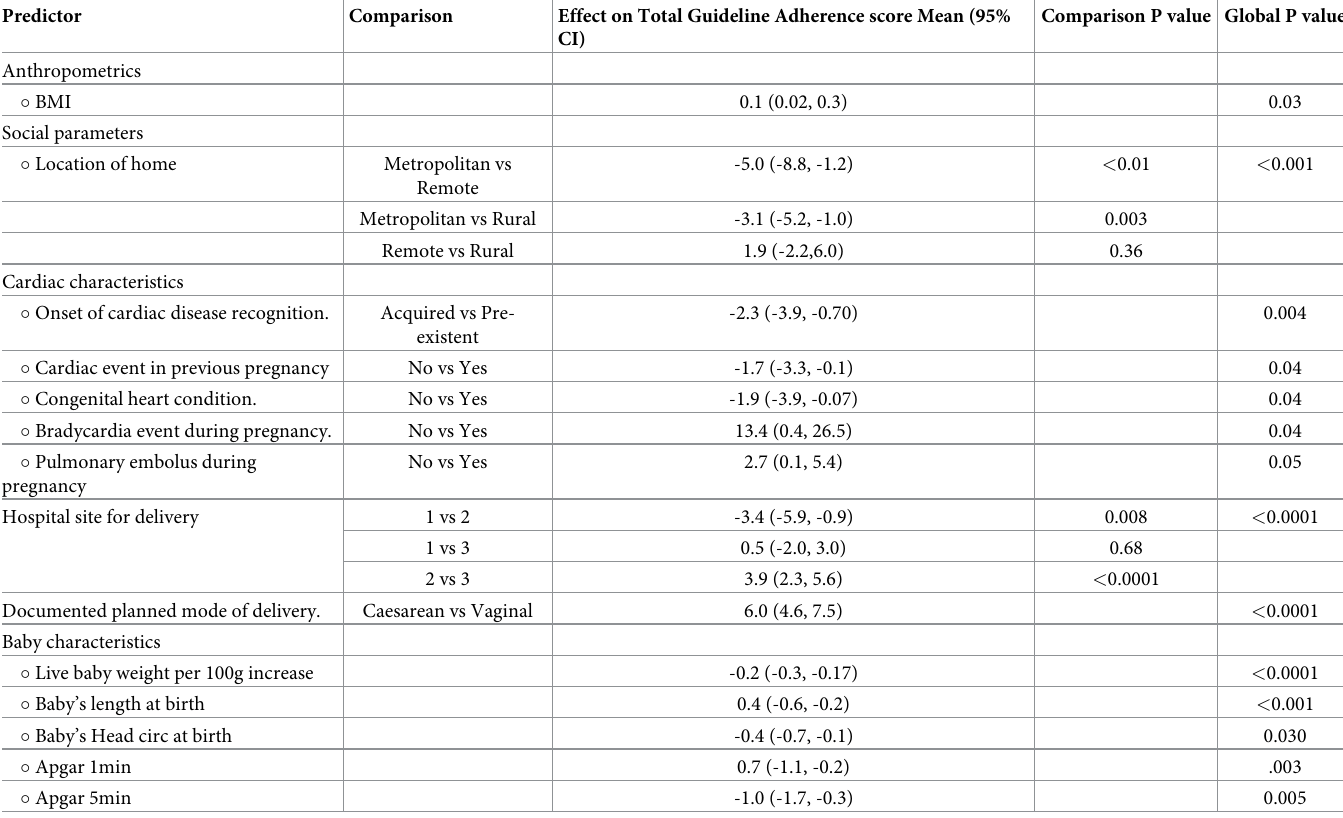
Table 2. A comparison of the mean adherence score versus various ‘predictors’ for all women with cardiac conditions during pregnancy.